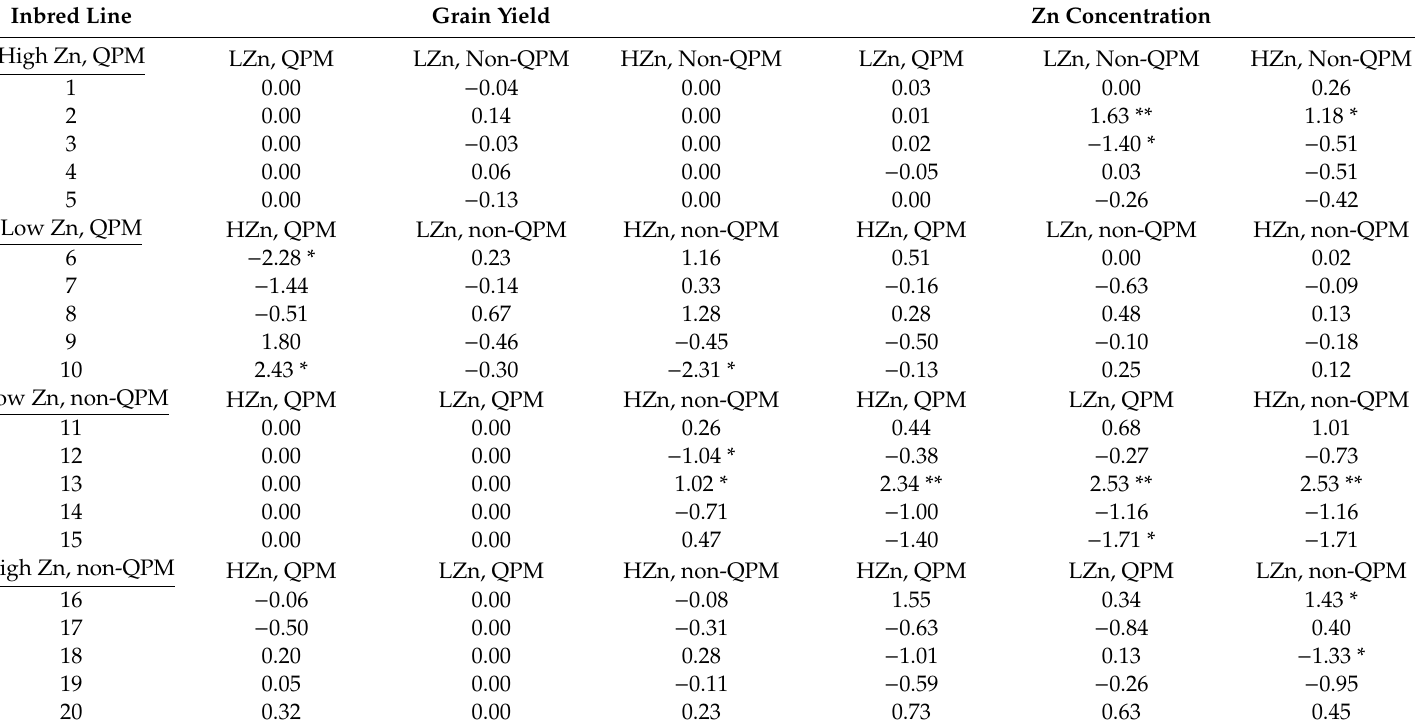
Table 6. General combining ability (GCA) e ff ects for grain yield and Zn across